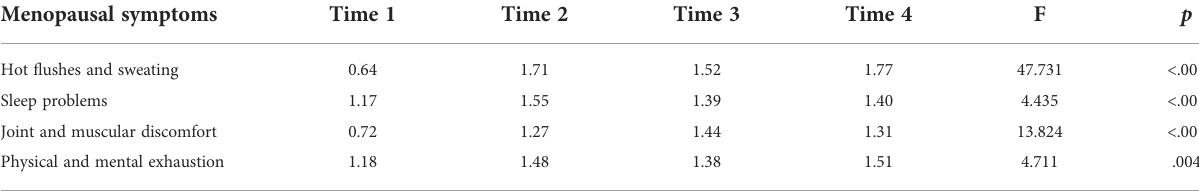
TABLE 2 Symptom scores at four time points.